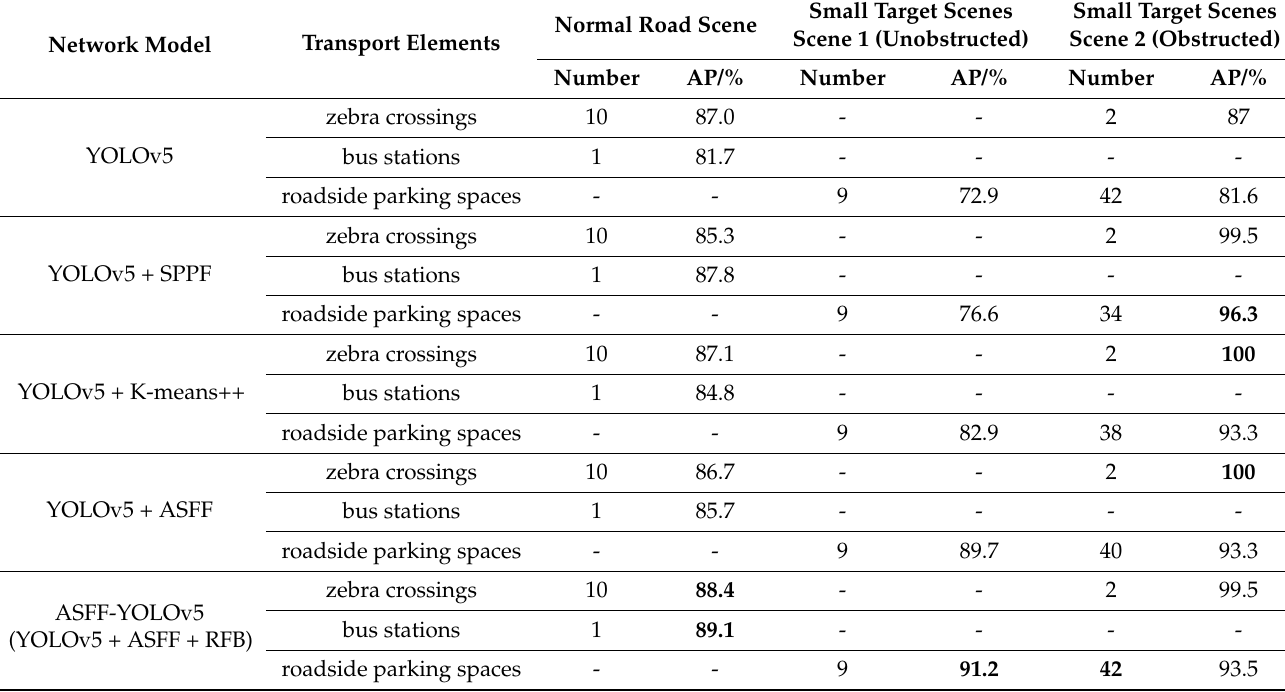
Table 6. Predicted results of ablation experiments in a small